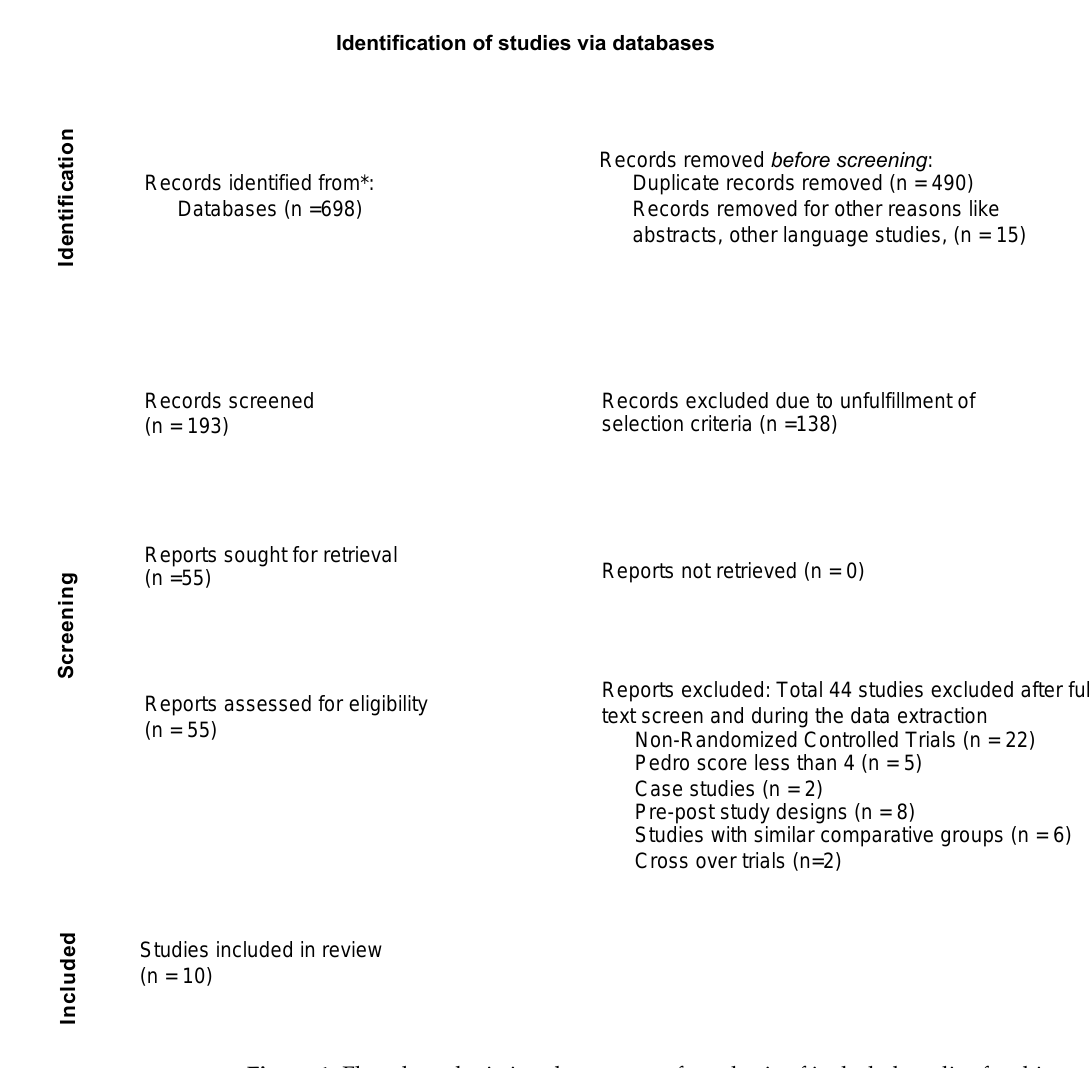
Figure 1. Flowchart depicting the process of synthesis of included studies for this review.